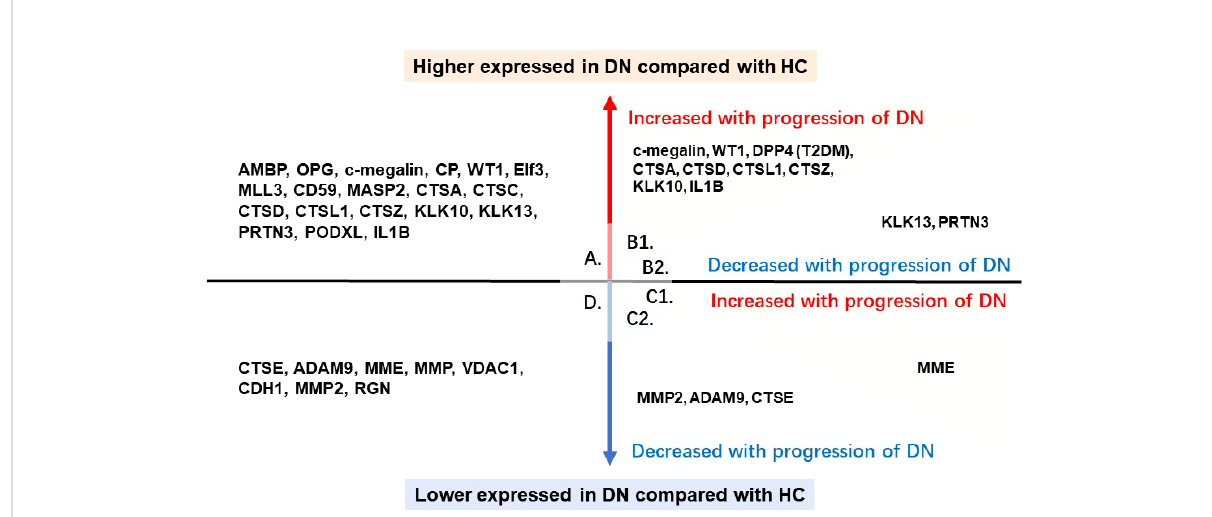
FIGURE 4 Proteins of urinary EV with signi fi cant difference. A. the proteins in urinary EV signi fi cantly upregulated in DN patients compared with healthy control; B1. the proteins in urinary EV signi fi cantly upregulated in DN patients compared with healthy control and also showed an increased trend with the progression of DN; B2. the proteins in urinary EV signi fi cantly upregulated in DN patients compared with healthy control, whereas showed a decreased trend with the progression of DN; C1. the proteins in urinary EV signi fi cantly downregulated in DN patients compared with healthy control, whereas showed an increased trend with the progression of DN; C2. the proteins in urinary EV signi fi cantly downregulated in DN patients compared with healthy control and also showed a decreased trend with the progression of DN; D. the proteins in urinary EV signi fi cantly downregulated in DN patients compared with healthy